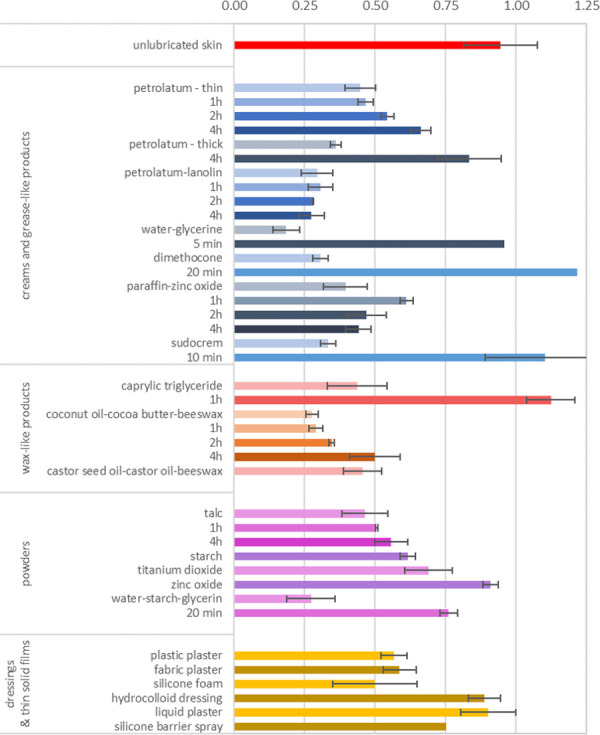
Overview of results.